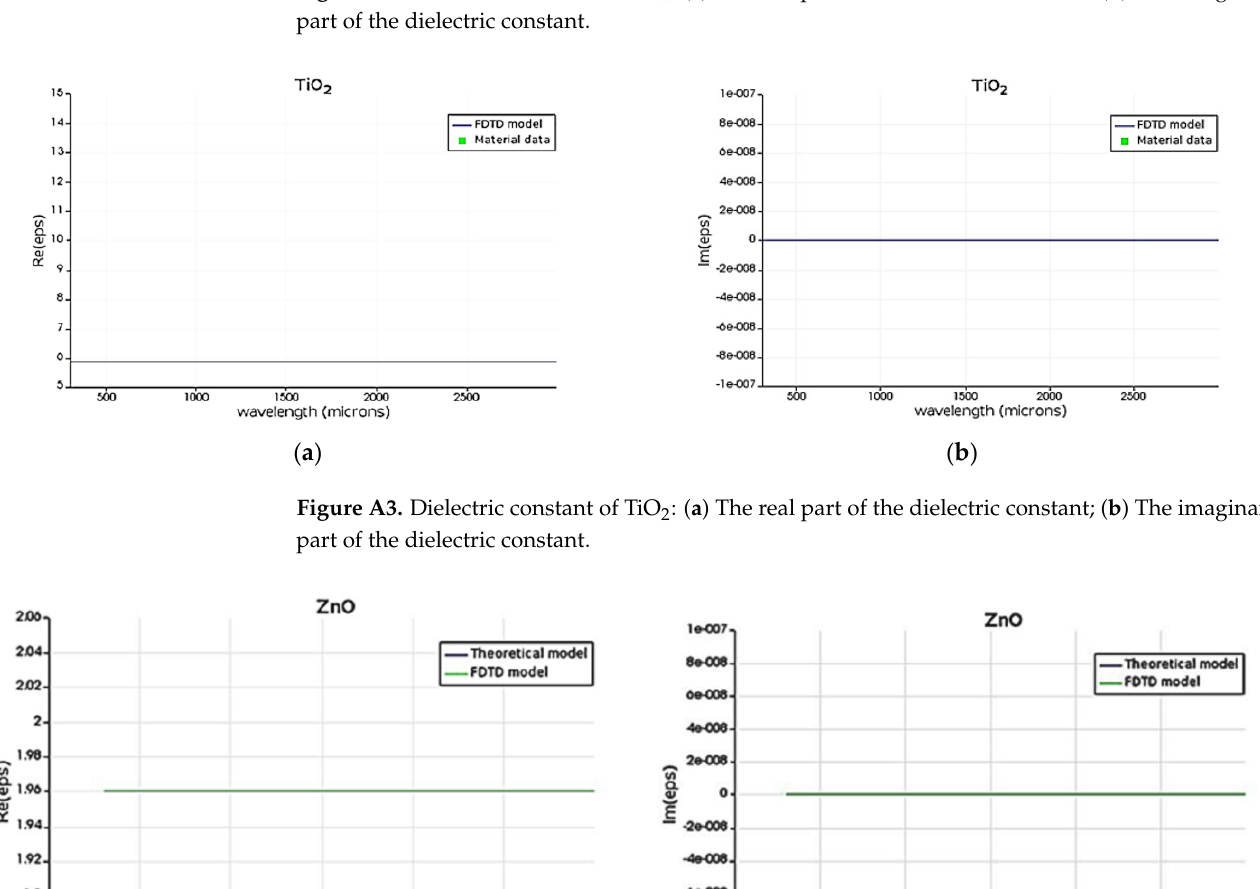
Figure A2. Dielectric constant of SiO 2 : ( a ) The real part of the dielectric constant; ( b ) The imaginary part of the dielectric constant.